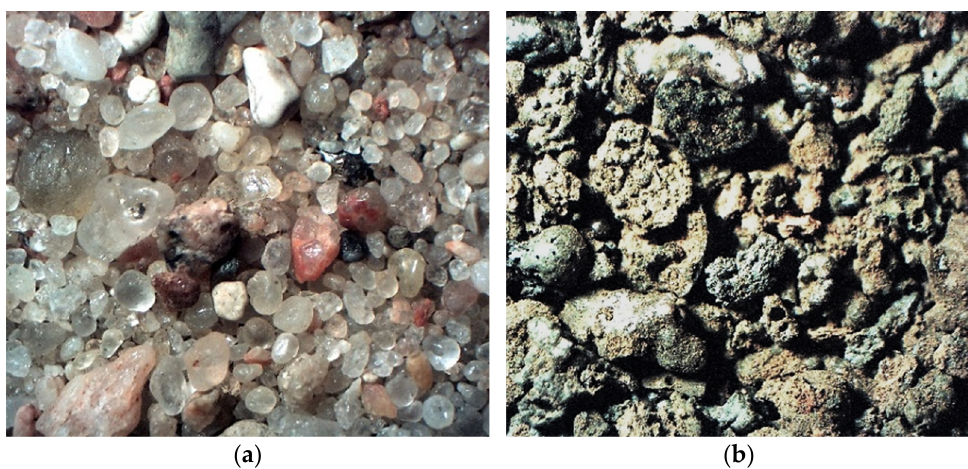
Figure 2. Grading of the natural aggregate.